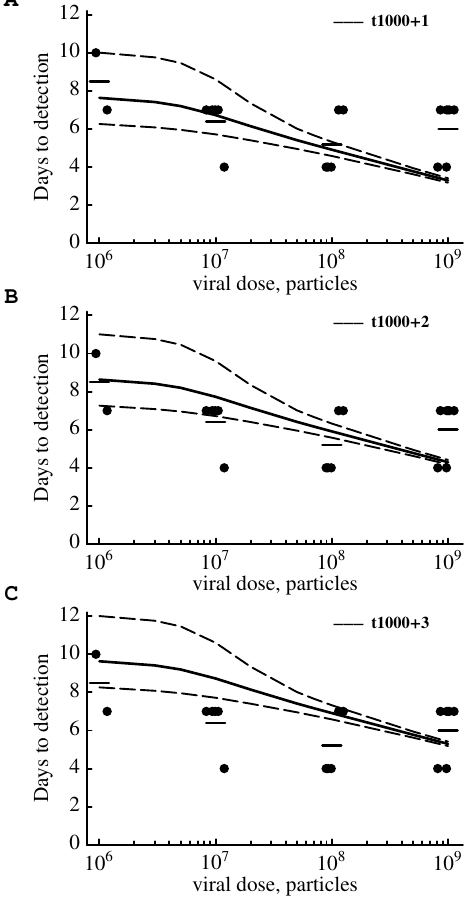
Figure 6. Stochastic simulations of the mathematical model do not accurately predict the change in the time to virus detection with increasing viral dose. In experiments, monkeys were challenged intrarectally with different doses of SIVmac251 and the time for virus detection in the blood was recorded [16]. We plot the time to virus detection for individual animals per dose (dots), the average of these times (bars), and the predictions from stochastic simulations of the mathematical model (solid lines) along with the 95% confidence intervals of the model predictions (dashed lines). In these simulations, we assume that exposure to 10 6 = 1 ), since in these experiments particles leads to an infection with one infectious virus ( V 0 only a single founder virus was detected [16]. Simulations were run with parameters for an intermediate mode of virus production (Table 1). Simulations were run stochastically until 1000 infectious viruses were generated ( t ) and then deterministically for 1 (panel A), 1000 2 (panel B), or 3 (panel C) additional days. Given the growth rate of the virus population, r , (Table 1) the virus population will expand approximately 4, 18, or 76 fold in 1, 2, or o 3 days,